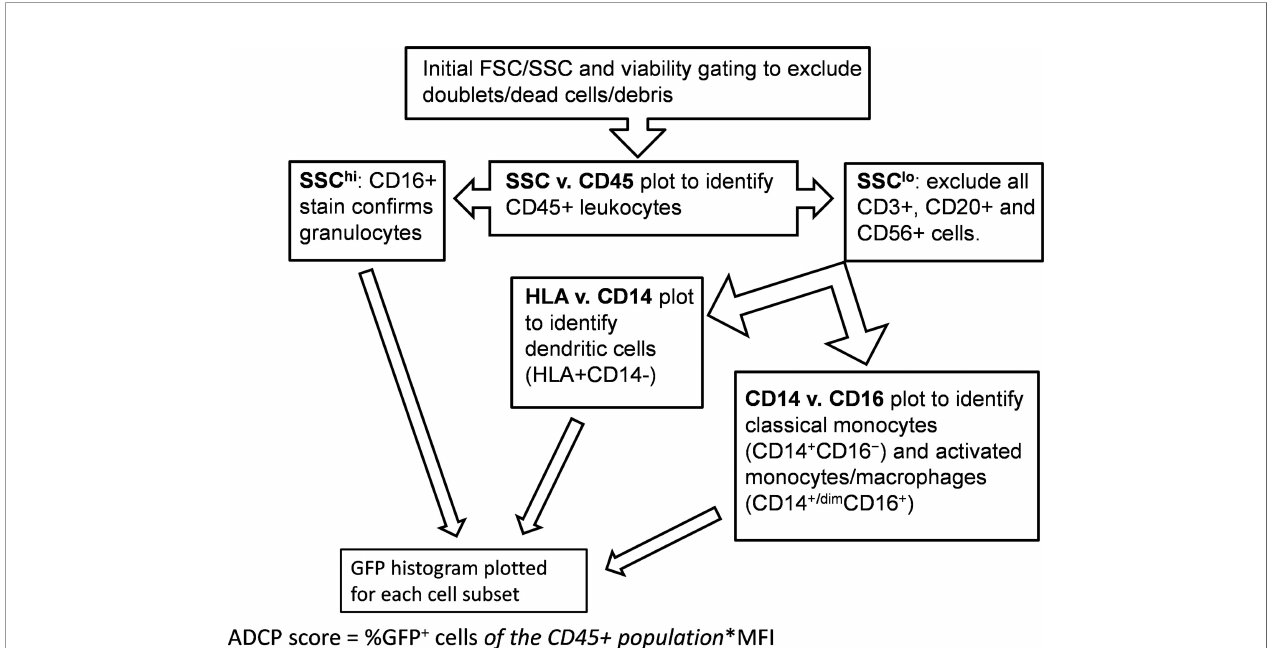
FIGURE 1 | Gating strategy. Flow cytometry was performed using an LSR Fortessa (BD) with initial gating on FACSDiva software. Analytical gating was performed using FCS